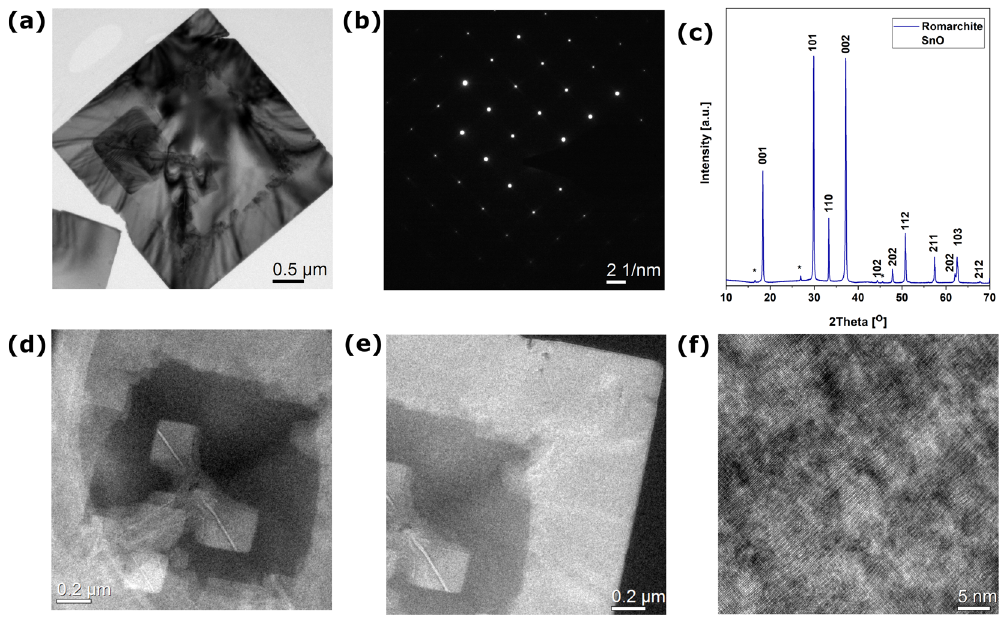
Fig. 4 TEM characterization of SnO platelets produced in the methanol:water (70:30) mixture. a TEM micrograph, b selected area electron diffraction, c X-ray diffraction pattern, d , e electron energy loss thickness maps and f HRTEM